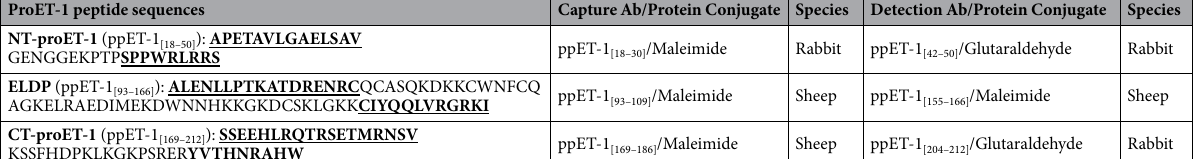
Table 1. Antibodies used for proendothelin-1 sandwich immunoassays. Amino acid numbering is based on the 212 amino acid sequence for preproendothelin-1 (ppET-1). Underlined sequences in bold type indicate peptides used as antigens to raise specific antisera for the development of capture and detection